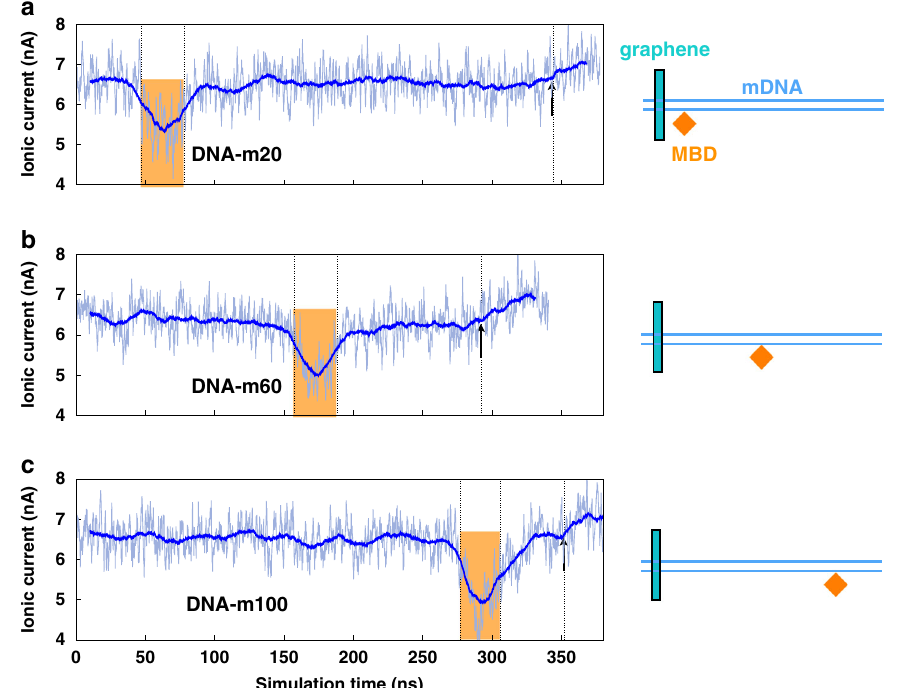
Fig. 2 Mapping DNA methylation with graphene nanopores. Recorded ionic current traces through a 5 nm graphene nanopore for mDNA- MBD1 complexes with a single MBD protein/methylation site present in three different positions: a 20 th , b 60 th , and c 100 th bp in a 120 bps mDNA (shown schematically on the right panel ). The thick lines represent the moving average with a window of 1 ns. The yellow rectangles highlight the time duration when the MB1 protein resides in the pore and the arrows denote the time instant when the complex leaves the pore